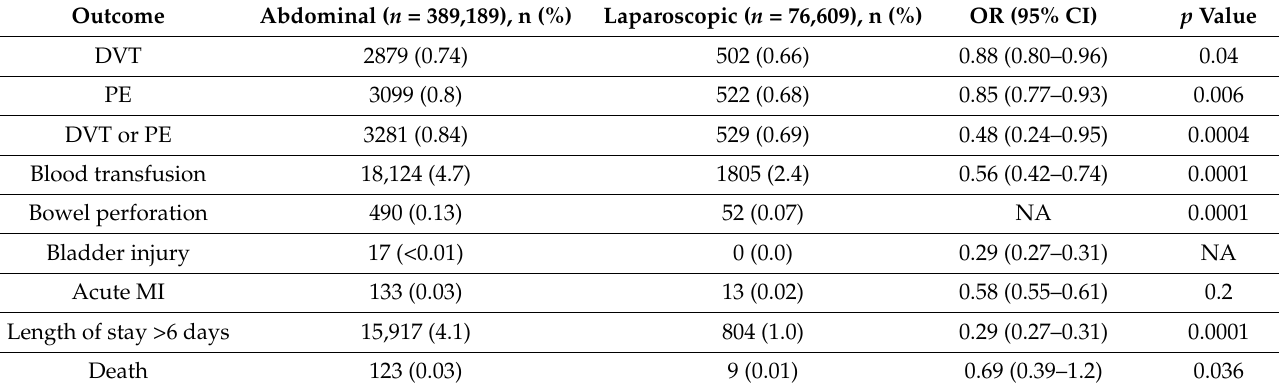
Table 1. Effect of hysterectomy approach on the risk of major morbidities and mortality. Reprinted by permission from Amir Wiser et al.: Springer Nature, Gynecological Surgery Abdominal versus laparoscopic hysterectomies for benign diseases: evaluation of morbidity and mortality among 465,798 cases, Amir Wiser et al., 2013